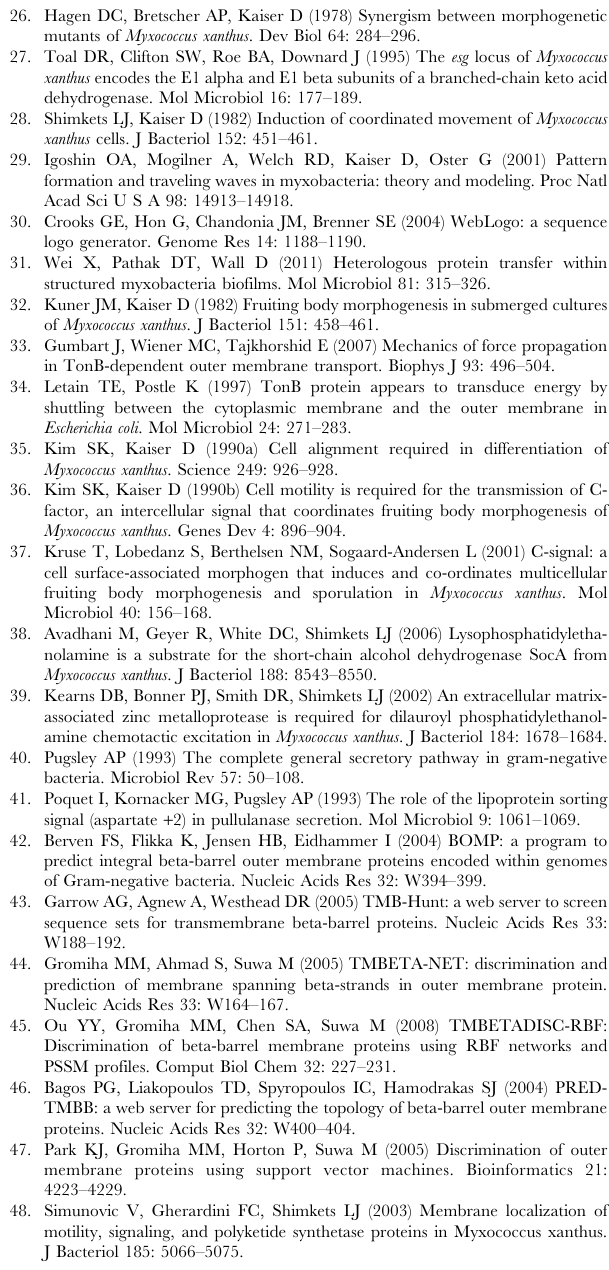
Table S1 228 OM proteins identified by bothTMBETA-SVM and TMBETADISC-RBF.